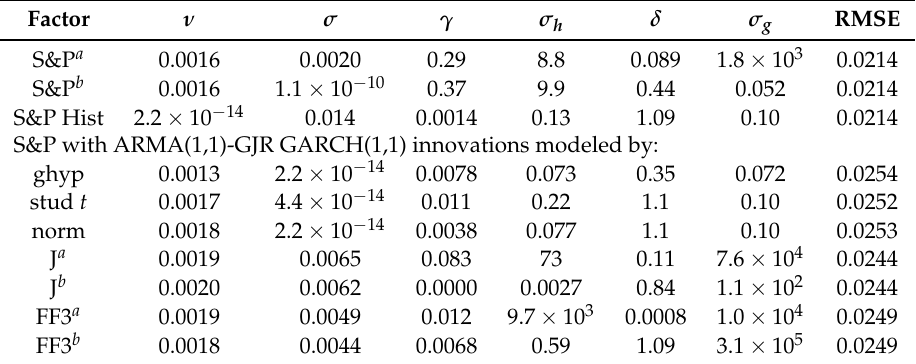
Table 1. Parameter estimates obtained from the minimization problem